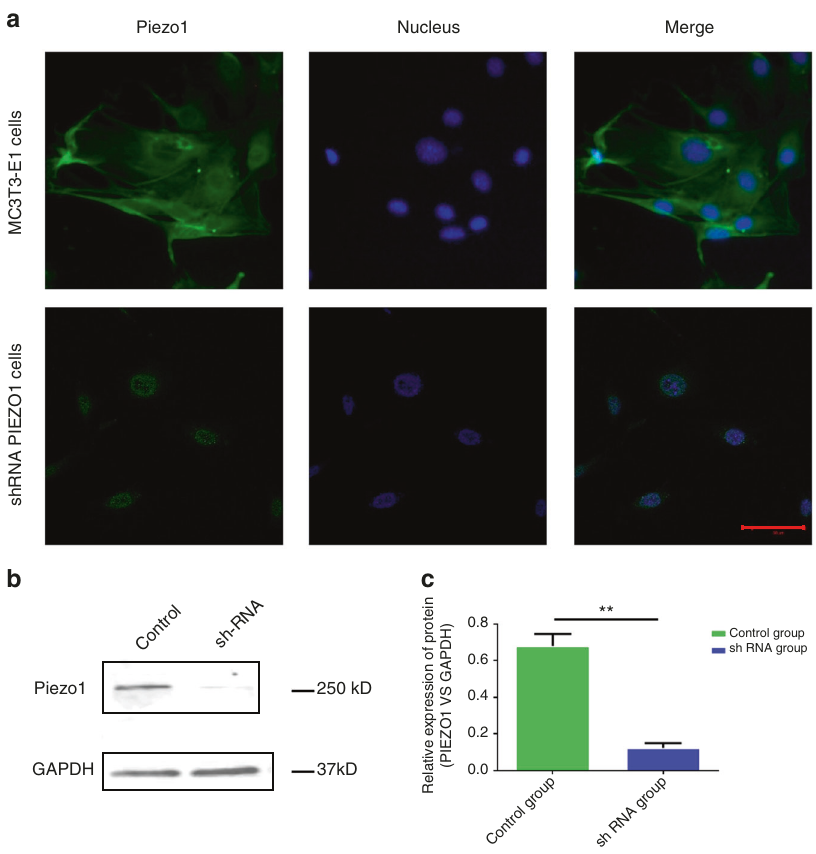
Fig. 1 Expression of Piezo1 in MC3T3-E1 and shRNA-Piezo1 MC3T3-E1 cells. a Piezo1 (green) was expressed on MC3T3-E1 cells and localized at the plasma membrane and nucleus (blue). The protein expression of Piezo1 was decreased in shRNA-Piezo1 cells, especially on the plasma membrane. Piezo1 was expressed only around the nucleus in the shRNA-Piezo1 cells. The scale bar is 50 μ m. b , c Western blot analysis showed that the Piezo1 protein expression in the shRNA-Piezo1 MC3T3-E1 group was signi fi cantly lower than that in the control group ( n = 3, P < 0.01, Student ’ s t